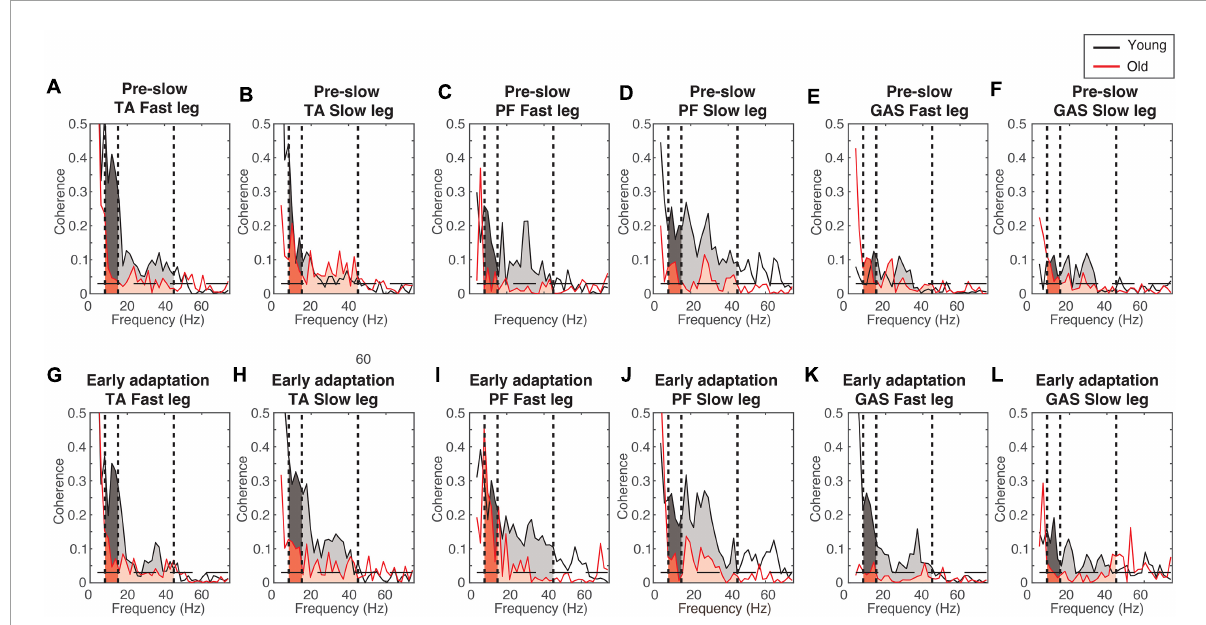
FIGURE4 Example coherence from a representative young and old participant. (A–F) Pre-slow coherence in the tibialis anterior (A,B) , plantarflexors (C,D) , and gastrocnemius (E,F) . (G–L) Early adaptation coherence in the tibialis anterior (G,H) , plantarflexors (I,J) , and gastrocnemius (K,L) . Dashed horizontal lines indicate the 95% confidence limit. Black = Young; Red = Old; Darker shaded areas = alpha-band frequency (8–15 Hz); Lighter shaded areas = beta-gamma band frequency (15–45 Hz).